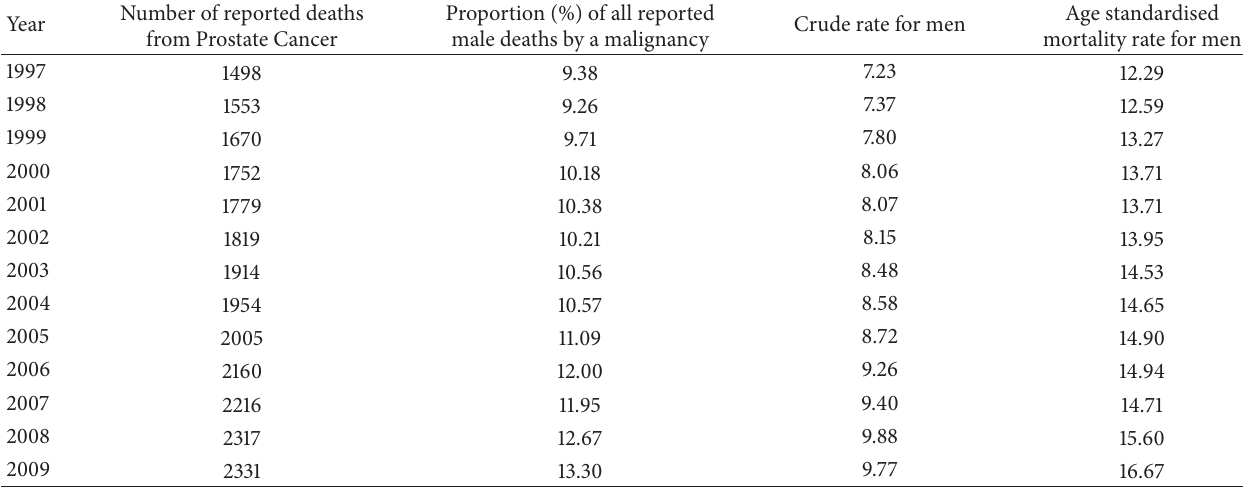
Table 3: Summary information for statistics South Africa mortality, from 1997 to 2009, ICD-10 code C61, prostate cancer. Year